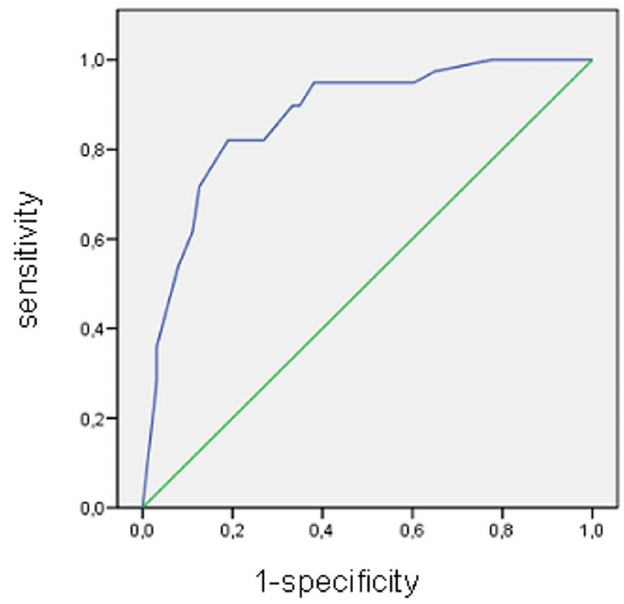
Figure 1. Receiver operating characteristic (ROC) curve for the predictive model (risk score equation) for AKI in severe rhabdomyolysis.